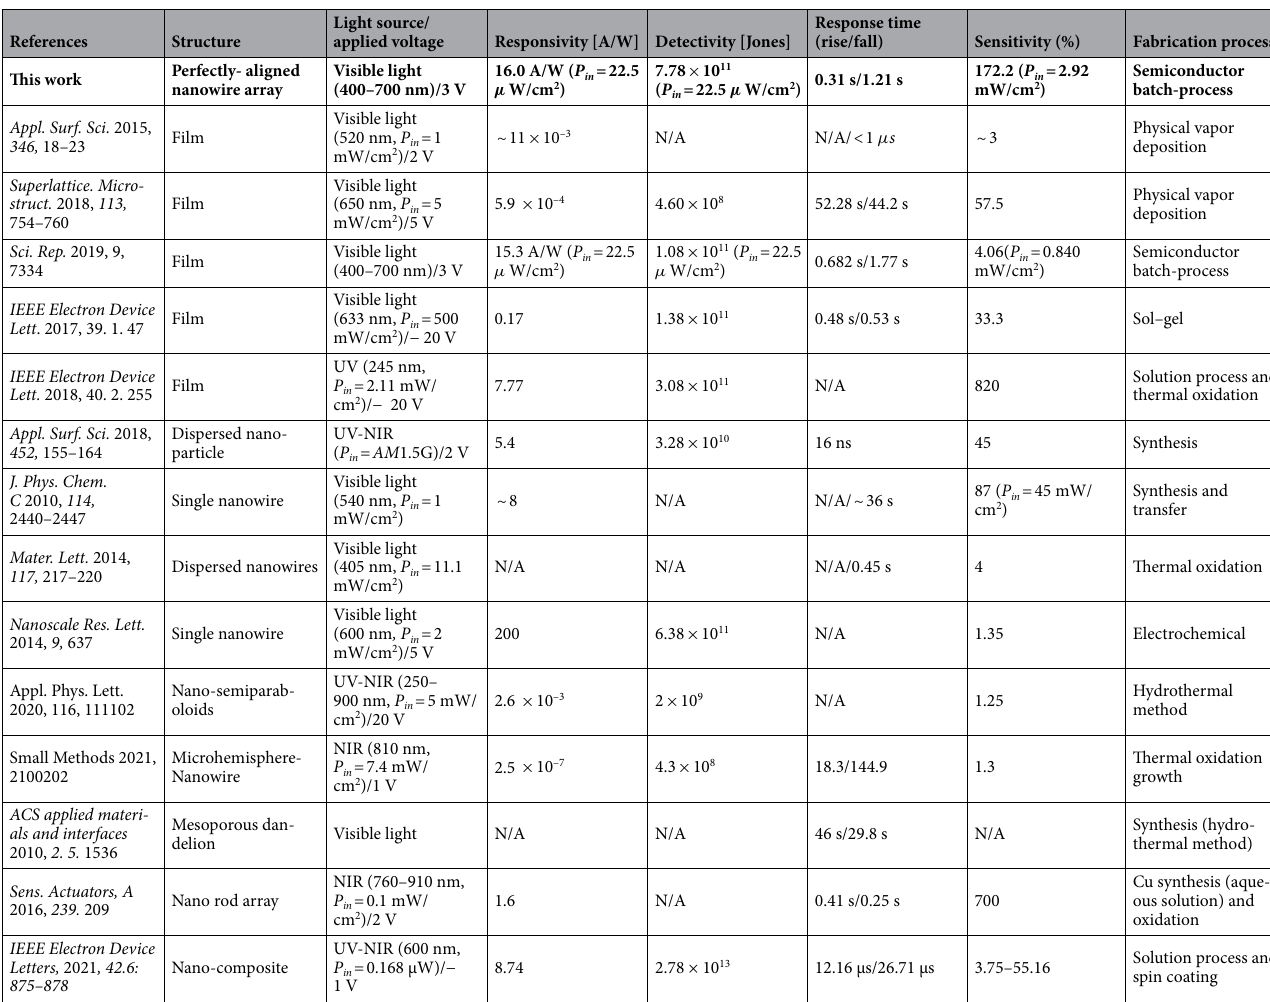
Table 1. Comparison of the performance of recently developed CuO